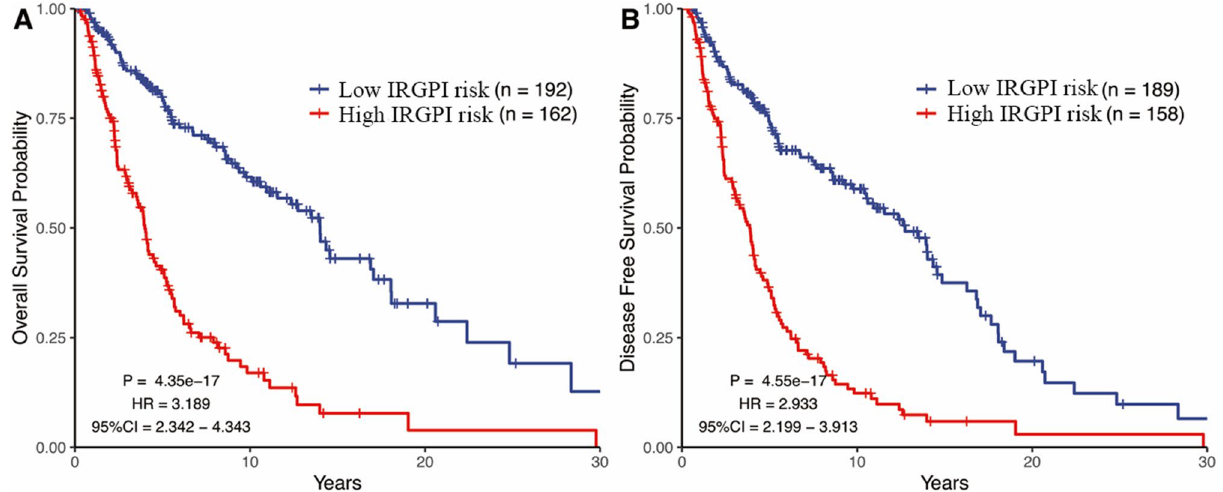
Figure 3. Kaplan – Meier curves analysis among different IRGPI risk groups in training cohort. ( A ) The impact of IRGPI on overall survival. ( B ) The impact of IRGPI on disease-free